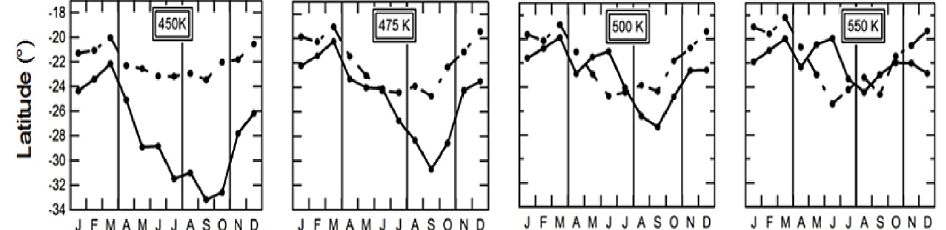
Figure 2. Equivalent latitude seasonal variation above Bauru (solid line) and Reunion (dashed) at 450, 475, 500 and 550K potential temper- ature levels. The stratosphere over Bauru, north of the tropical jet in the winter, is much more influenced by the mid-latitudes.